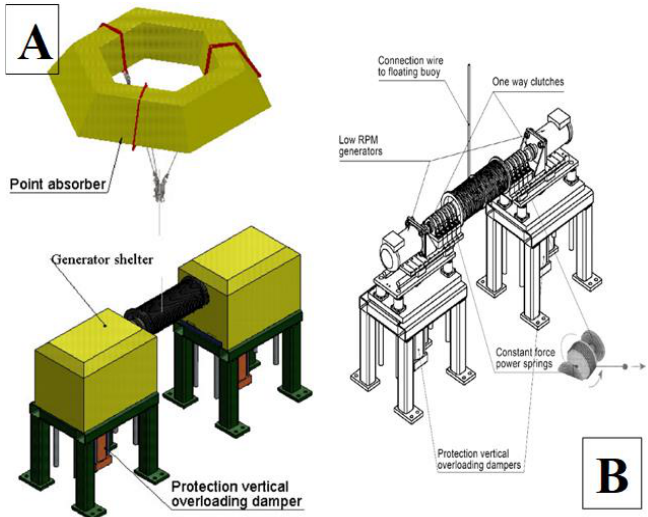
Fig. 2. Generator concept, [9]